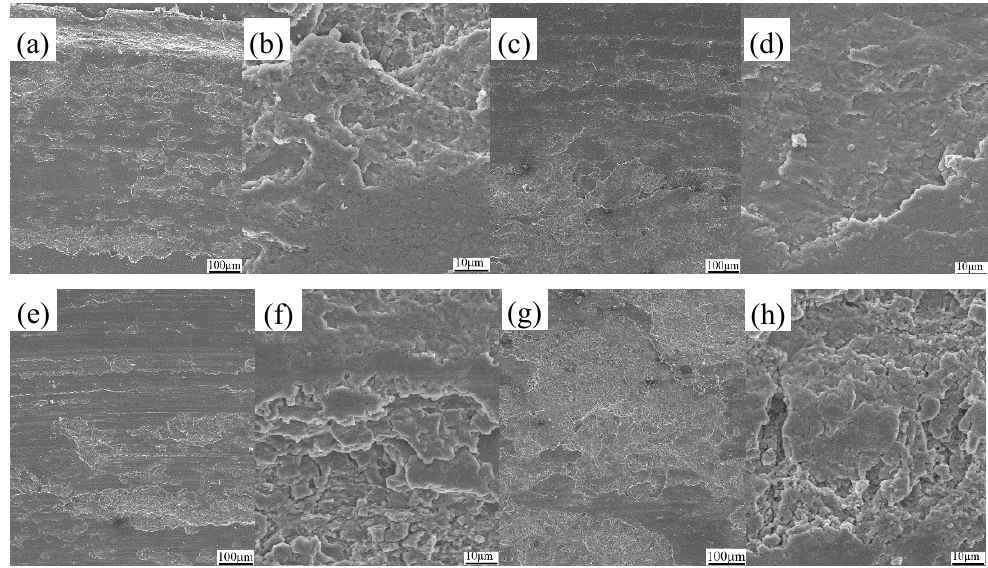
Figure 14. SEM images of the wear tracks on 4.5 wt.% TiB 2 / 7075 specimens cast at 720 °C under di ff erent frictional loads: ( a , b ) 30 N, ( c , d ) 60 N, ( e , f ) 90 N, and ( g , h ) 120